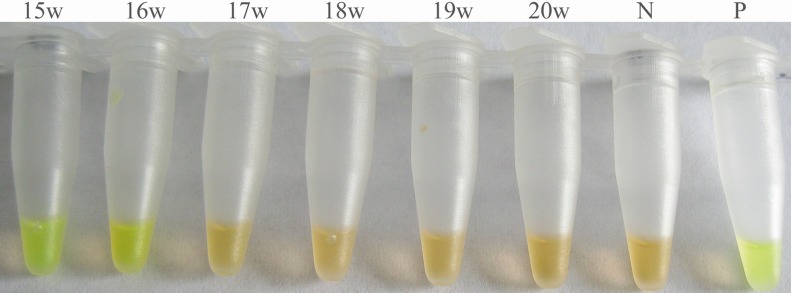
Detection of Schistosoma japonicum DNA in sera of rabbits after treatment with praziquantel by LAMP.Serum samples were collected from 15weeks to 20 weeks post-infection (8–13 weeks post-treatment). Tube N, serum of non-infected rabbits (negative control); tube P, DNA of S. japonicum adult worm (positive control).